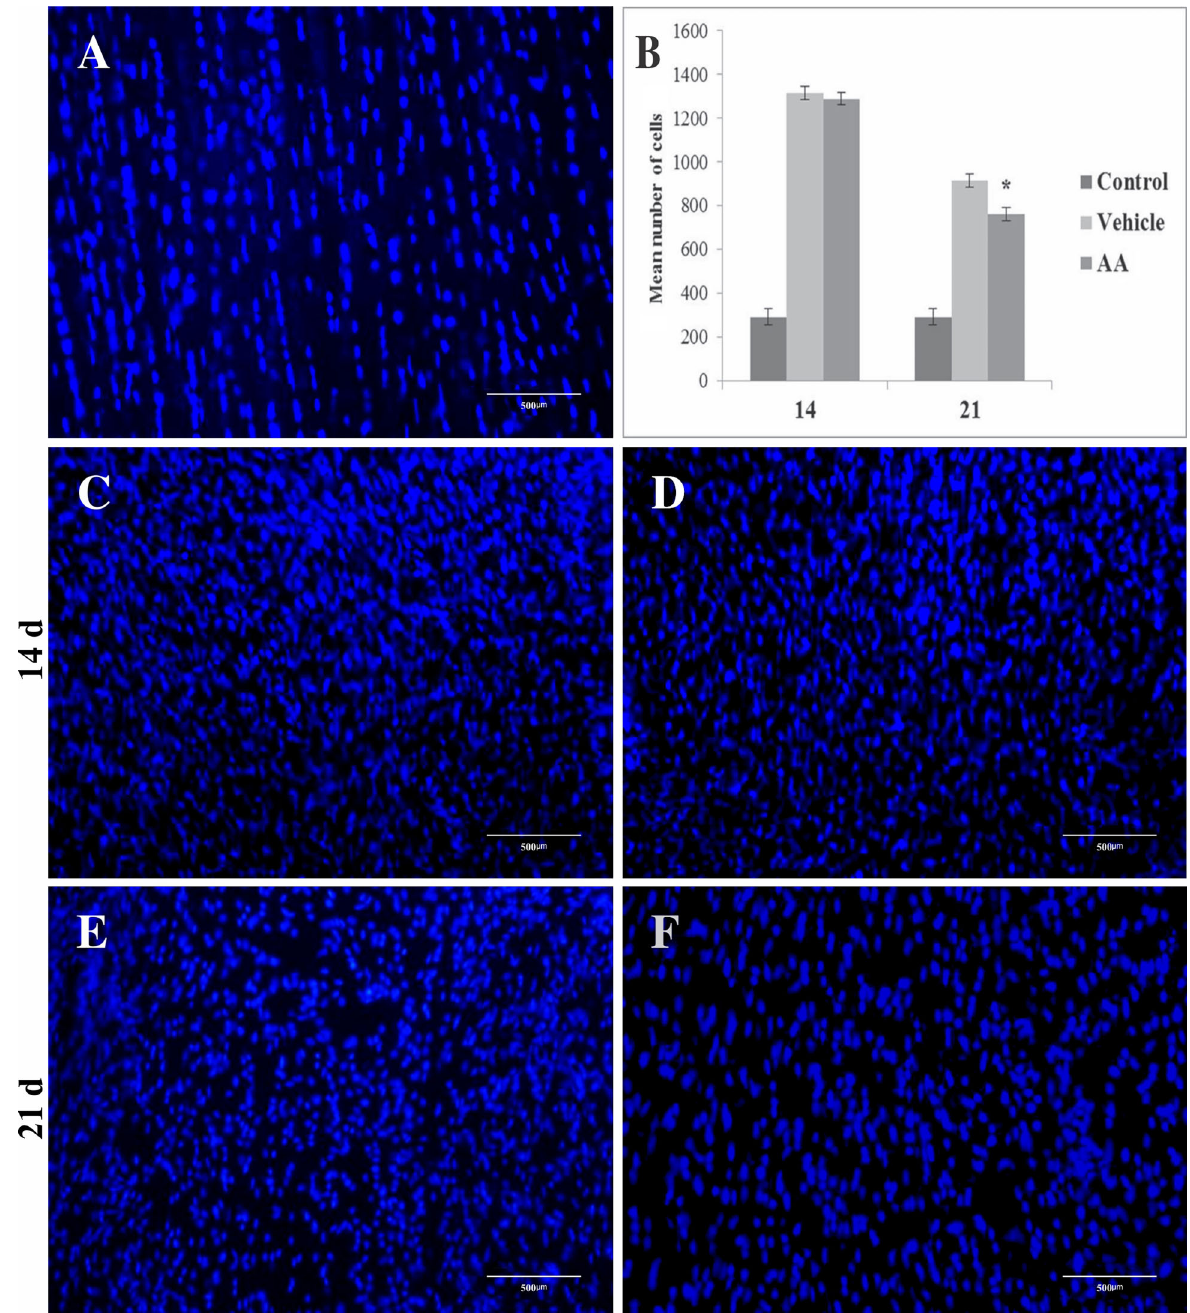
Figure 2. Photomicrographs of DAPI staining in tendon tissue of control group ( A ), vehicle group at 14 ( C ) and 21 days post-surgery ( E ), and ascorbic acid (AA) group at 14 ( D ) and 21 days post-surgery ( F ). Cell number data are reported as means ± SD for n=3 ( B ). *P o 0.01 vs vehicle (ANOVA and Tukey ’ s post-test). Scale bar: 500 m